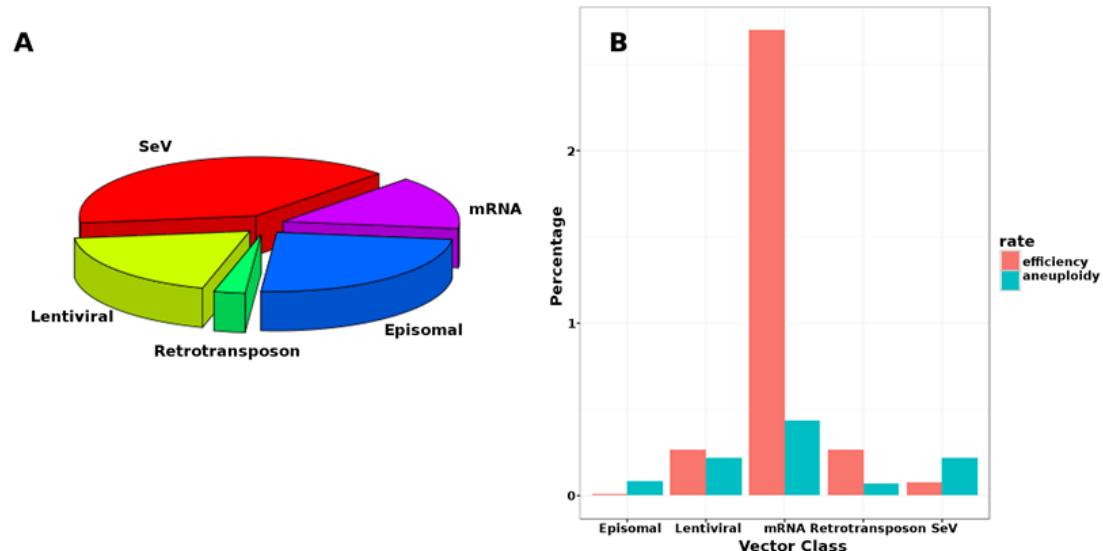
Figure 3. Adoption and performance of alternative vector classes. ( A ) Usage of different classes by labs generating iPSC from fibroblasts or red blood cells; ( B ) Reprogramming efficiency and reciprocal of aneuploidy rates (as percentages) for each vector. Plotted using R computing language [54] and based on data in Schlaeger et al. (2014) [23].